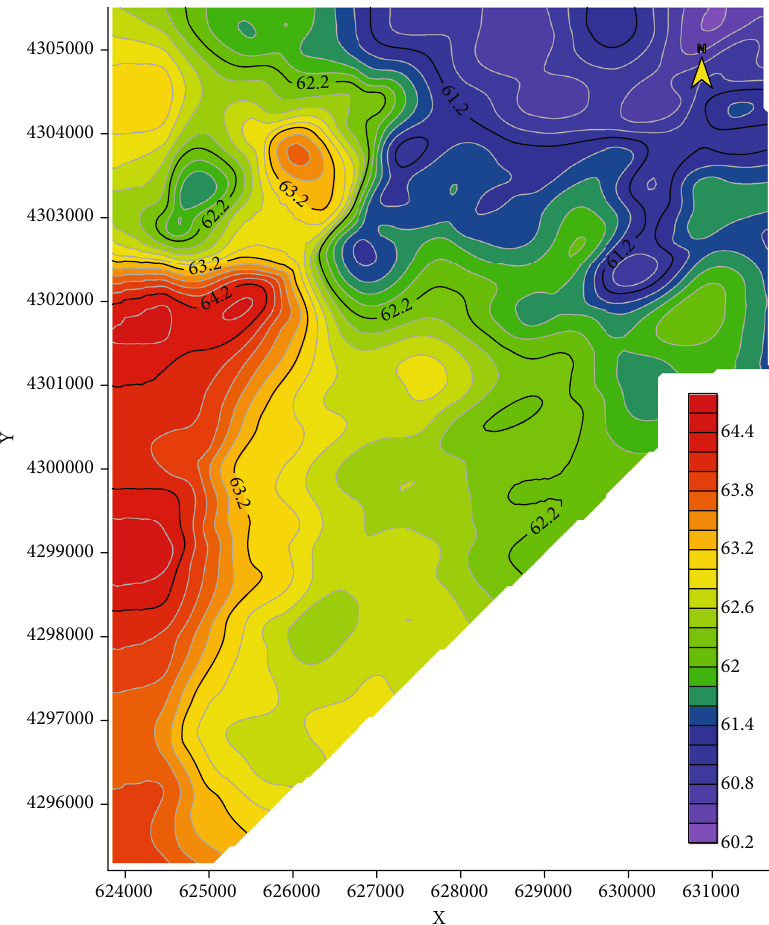
Figure 8: Isogram of the southeast angle of the maximum principal stress in the key stratum after loading tectonic stress ( °